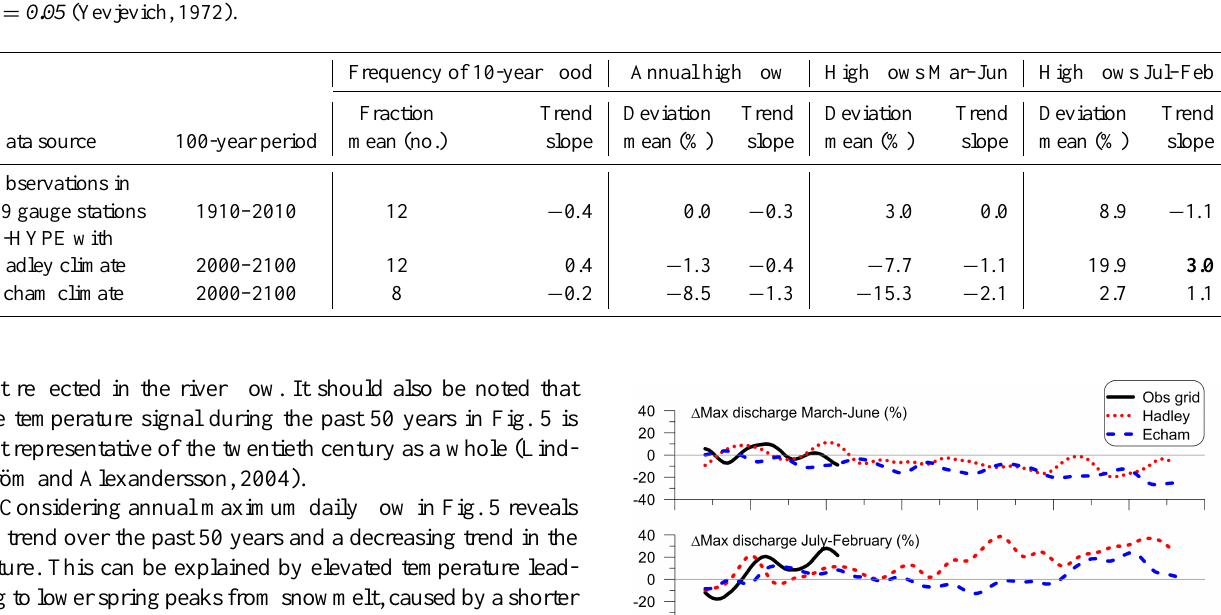
Table 2. Summary of analysis of daily high flows in observed time series representing 100 years in the past and a modeled time series for 100 years in the future. Deviation (%) in relation to the mean of the reference period (1961–1990) and trends (slope as percent per decade) are given for annual high flows, frequency of 10-year flood, and spring and autumn flood. Bold numbers indicate a significance level of P = 0.05 (Yevjevich, 1972).